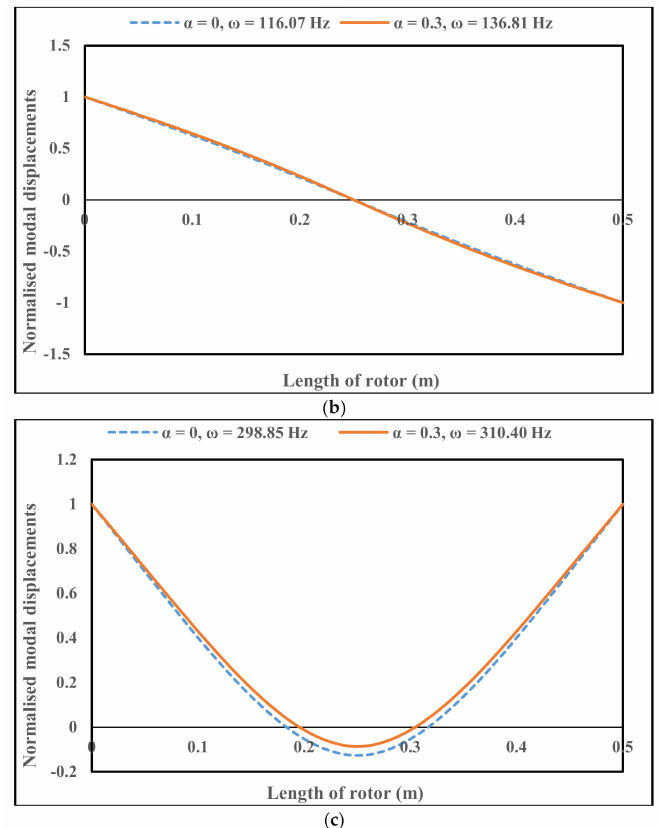
Figure 6. ( a ) First mode shape of a porous and non-porous FG rotor–bearing system; power law index (k) = 0.5. ( b ) Second mode shape of a porous and non-porous FG rotor–bearing system; power law index (k) = 0.5. ( c ) Third mode shape of a porous and non-porous FG rotor–bearing system; power law index (k) =